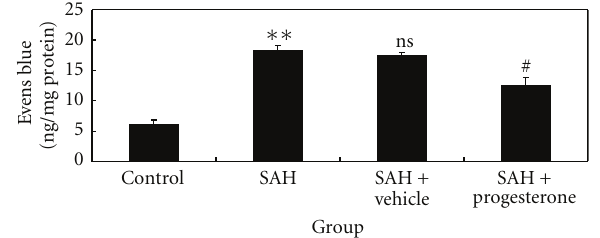
Figure 6: Alterations in Evans blue extravasation in control group ( n = 6), SAH group ( n = 6), SAH + vehicle group ( n = 6), and SAH + progesterone group ( n = 6). SAH could induce a marked increase of BBB extravasation in the rat brain compared with control group. After progesterone administration, the Evans blue extravasation was significantly reduced as compared with SAH + vehicle group. ∗∗ P < . 01 versus control group, # P < . 05 versus SAH + vehicle group, ns P > . 05 versus SAH